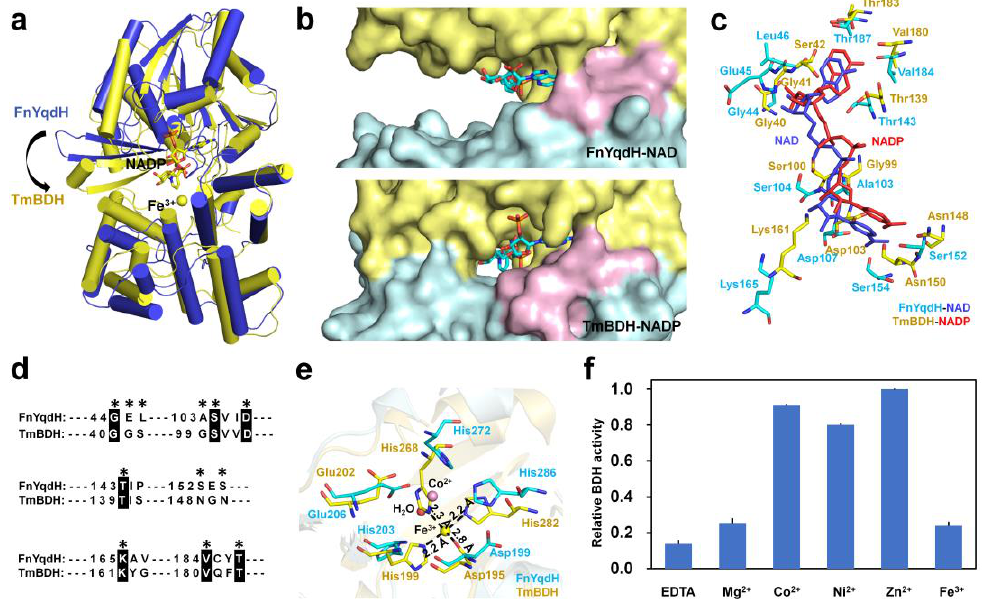
Figure 6. Structural and functional comparison of FnYqdH with TmBDH. ( a ) Superposition of monomeric structures of FnYqdH (blue) and TmBDH (yellow). ( b ) Comparison of the surface structures of FnYqdH-NAD-Co 2+ and TmBDH. ( c ) Superposition of NAD(P)H-binding sites of FnYqdH-NAD-Co 2+ (cyan) and TmBDH (yellow). NADH and NADPH are colored dark blue and red, respectively. ( d ) Partial sequence alignment of FnYqdH and TmBDH. The NADPH-binding site of TmBDH is indicated by an * . A black background highlights conserved residues. ( e ) Superposition of the metal ion-binding sites of FnYqdH-NAD-Co 2+ (cyan) and TmBDH (yellow). Co 2+ , Fe 3+ , and water molecules are colored pink, red, and yellow, respectively. The dark dashed lines indicate interactions between Fe 3+ and amino acids in TmBDH. ( f ) Effect of metal ions on the enzymatic activity of TmBDH.